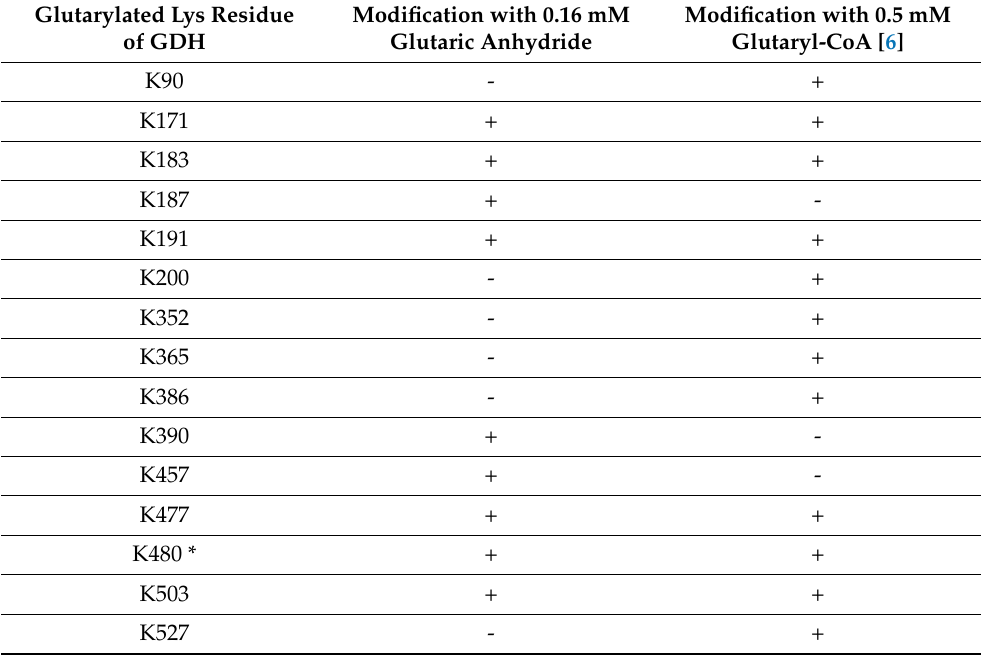
Table 1. Glutarylated lysine residues of the GDH peptides determined by mass spectrometry analysis of the purified enzyme after modification with 0.16 mM glutaric anhydride (this work) and 0.5 mM glutaryl-CoA [6]. * Lysine residue preceded by glycine